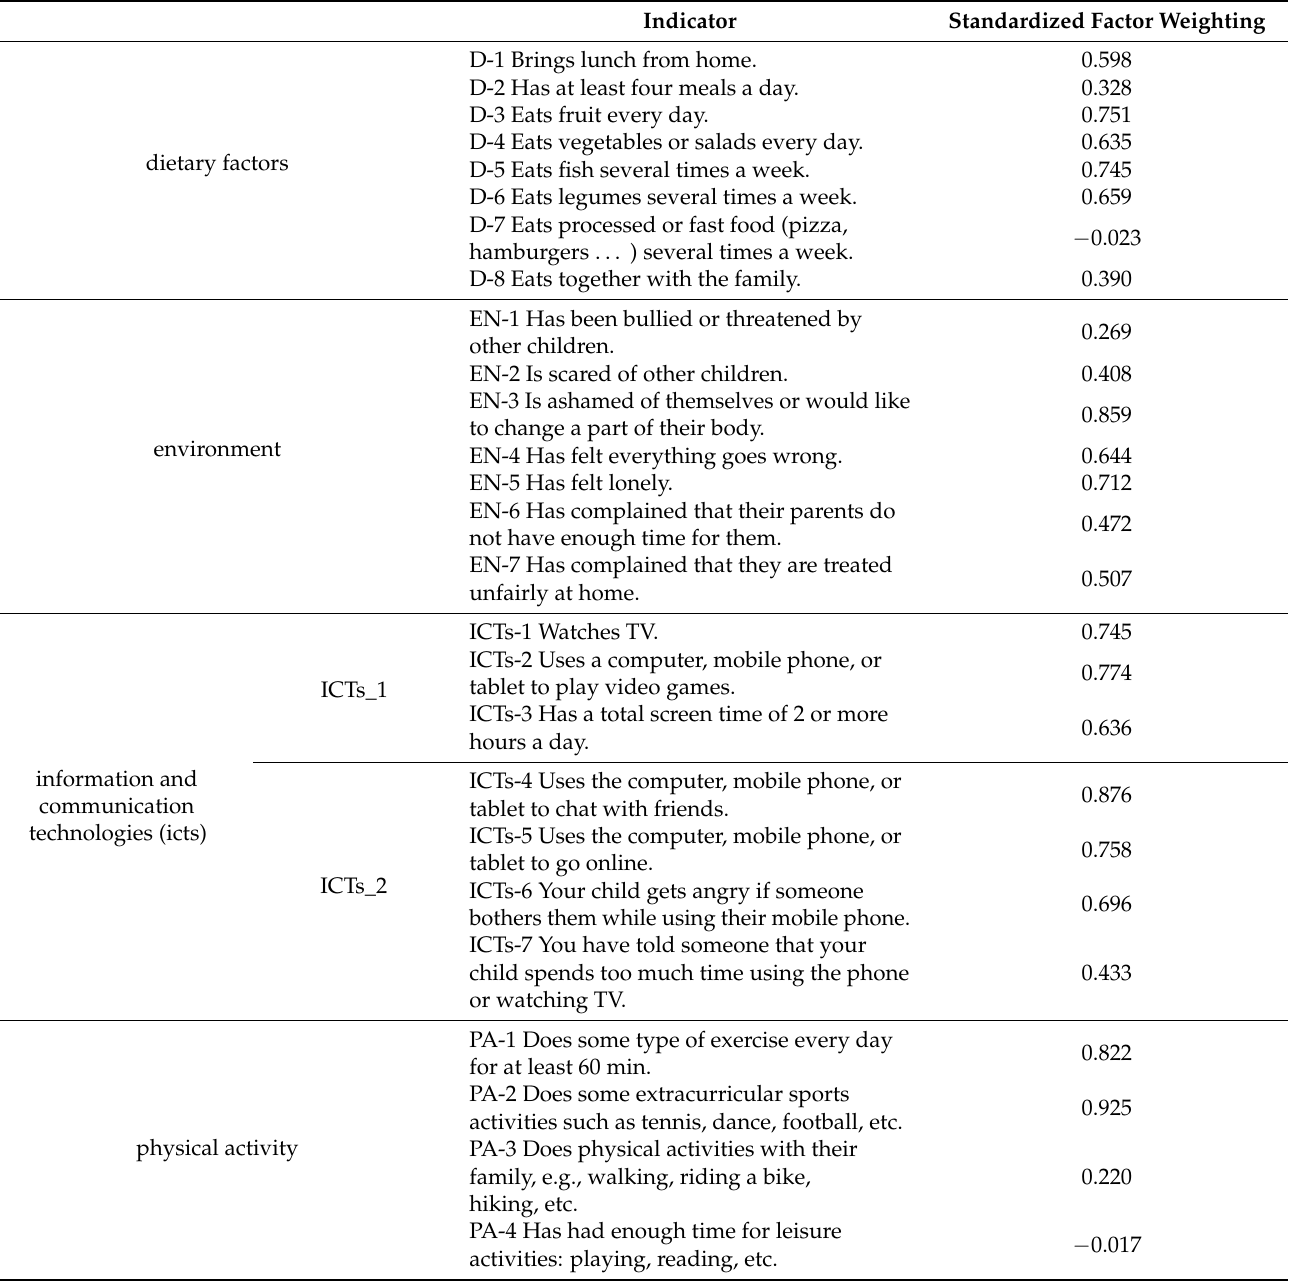
Table 3. ENHASA questionnaire and weighting factor of each item post multivariate analysis.